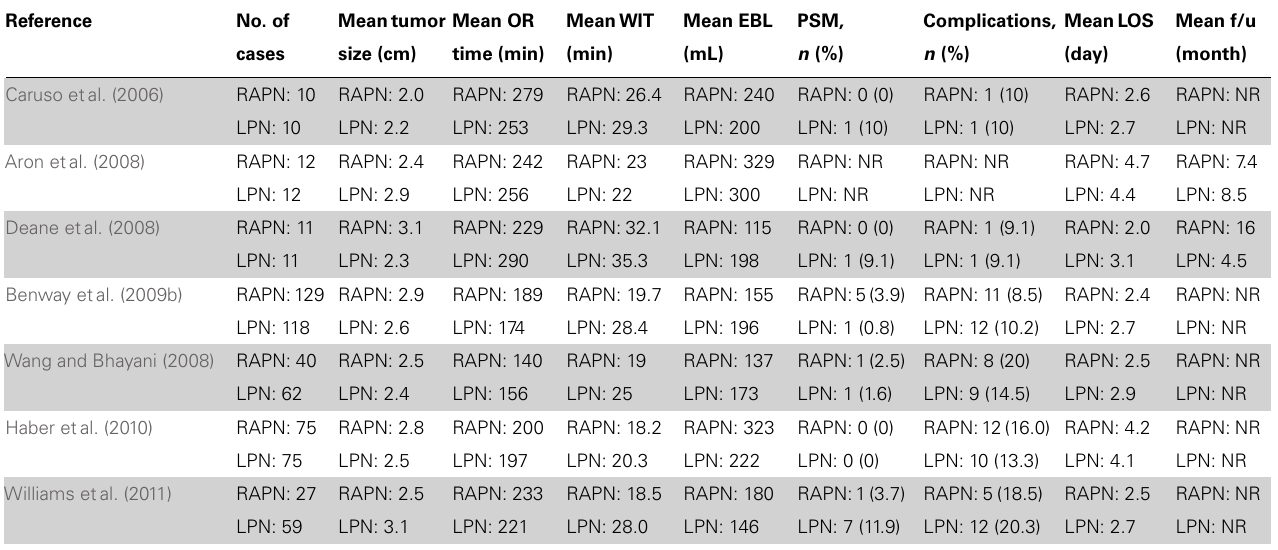
Table 2 | Series comparing RAPN vs. LPN.